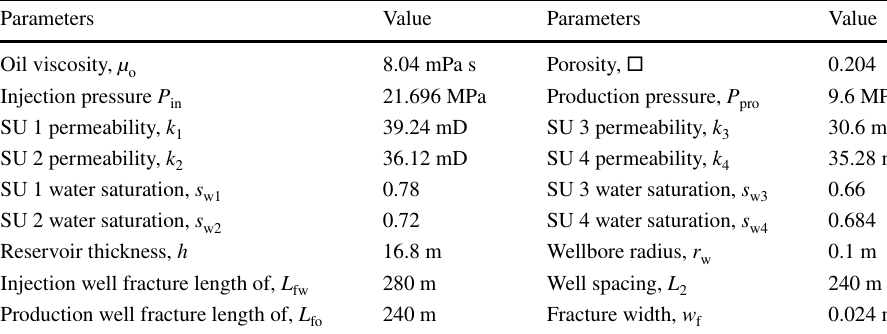
Table 2 The value of the input parameters